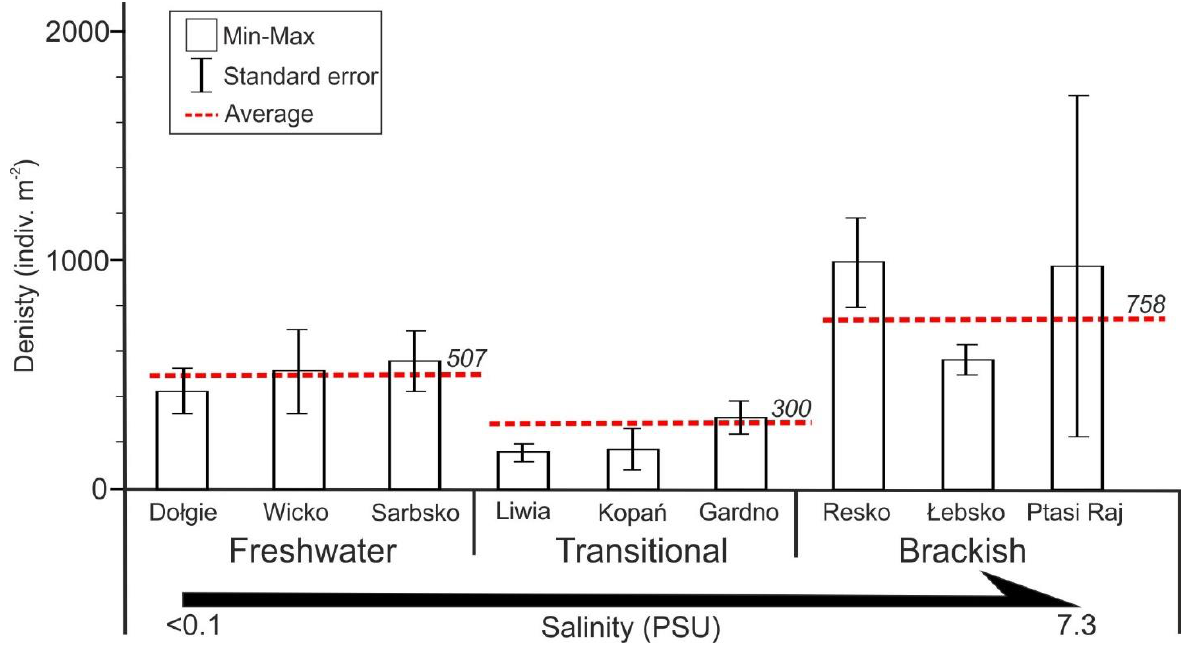
Figure 4. Density (10 3 indiv. m −2 ) of benthic fauna for each lake. Bar chart (± standard error of mean) and dashed red line—average density for a lake type.